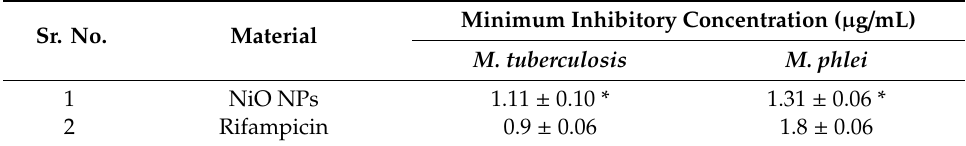
Table 1. Minimum inhibitory concentration activity of NiO NPs against M. tuberculosis and M. phlei.